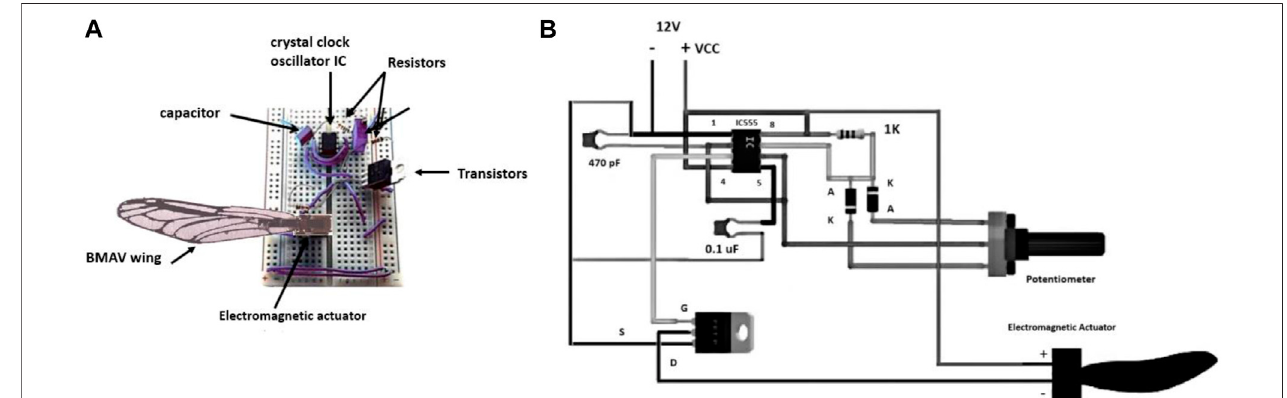
FIGURE 3 | Flapping mechanism: (A) Actual setup, (B) Electronic overview diagram.